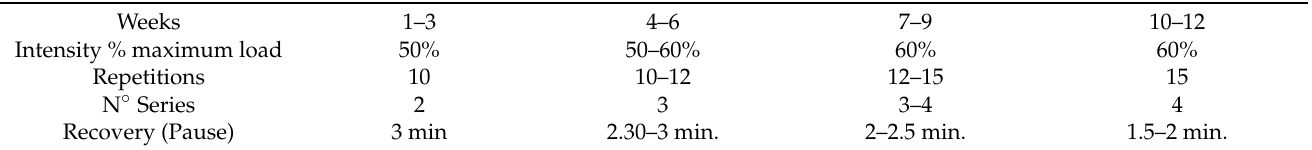
Table 2. Muscle Strength Exercise